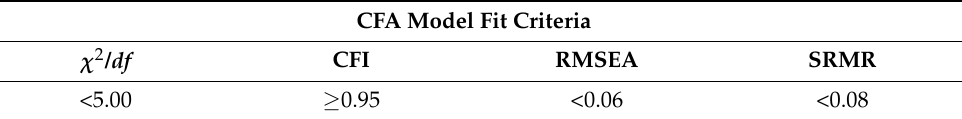
Table 2. Criteria used to evaluate CFA model